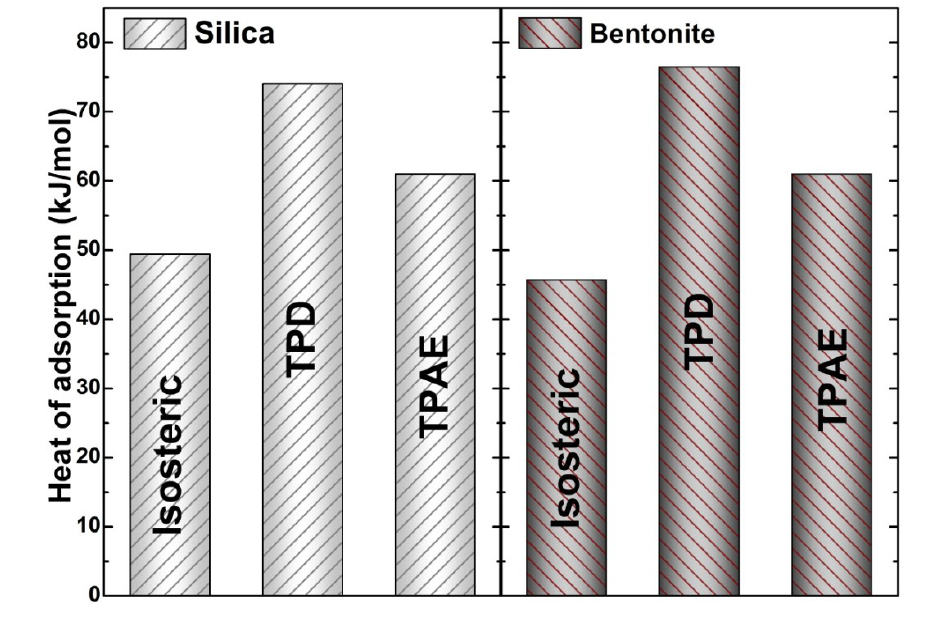
Figure 7. Graphical illustration of the heat of adsorption values obtained using isosteric, TPD, and TPAE methods with bentonite and